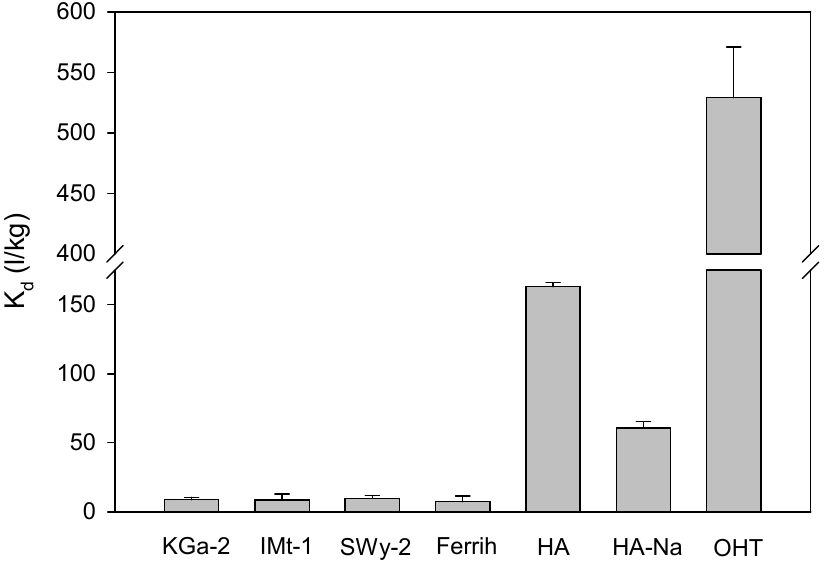
Figure 2. Distribution coefficients for rac ‐ pulegone on model soil constituents and on OHT. KGa ‐ 2: Georgia kaolinite; IMt ‐ 1: Montana illite; SWy ‐ 2: Wyoming montmorillonite; Ferrih: ferrihydrite; HA: humic acid (acid form); HA ‐ Na: humic acid (sodium salt); OHT: oleate ‐ modified hydrotalcite.